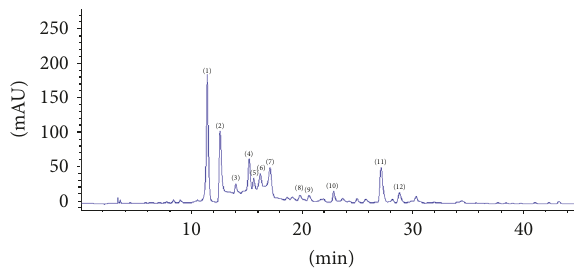
Figure 2: Representative chromatogram of phenolic compounds in umezu ( 𝜆 = 280 nm). (1) Neochlorogenic acid; (2) unknown; (3) unknown; (4) chlorogenic acid; (5) unknown; (6) unknown; (7) cryptochlorogenic acid; (8) unknown; (9) caffeic acid; (10) unknown; (11) p-coumaric acid; (12)